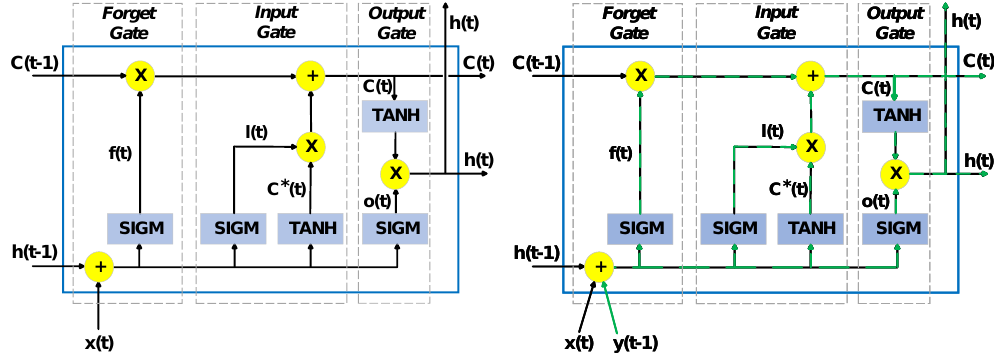
Figure 1. LSTM generic unit ( left ) together with an LSTM unit with teacher forcing ( right ). This figure originates from